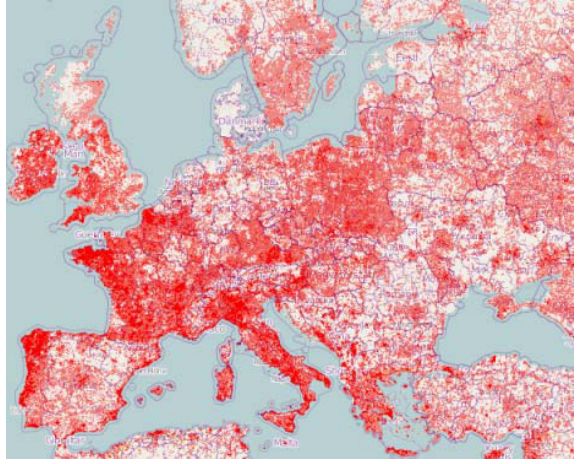
Figure 6: The OSM “no-name” project.